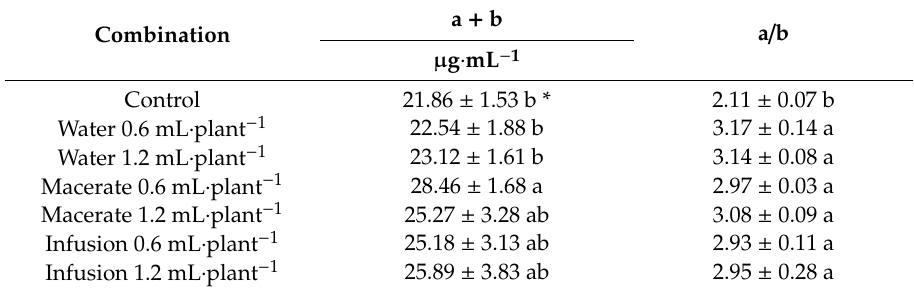
Figure 1. Concentration of chlorophyll a and b in potato leaves treated by extracts form Artemisia vulgaris L. (average of three independent experiments and SD). Values followed by different small letters are significantly different at p < 0.05. Table 2. Plant pigments content depending on the plant extract used (average of three independent experiments ±